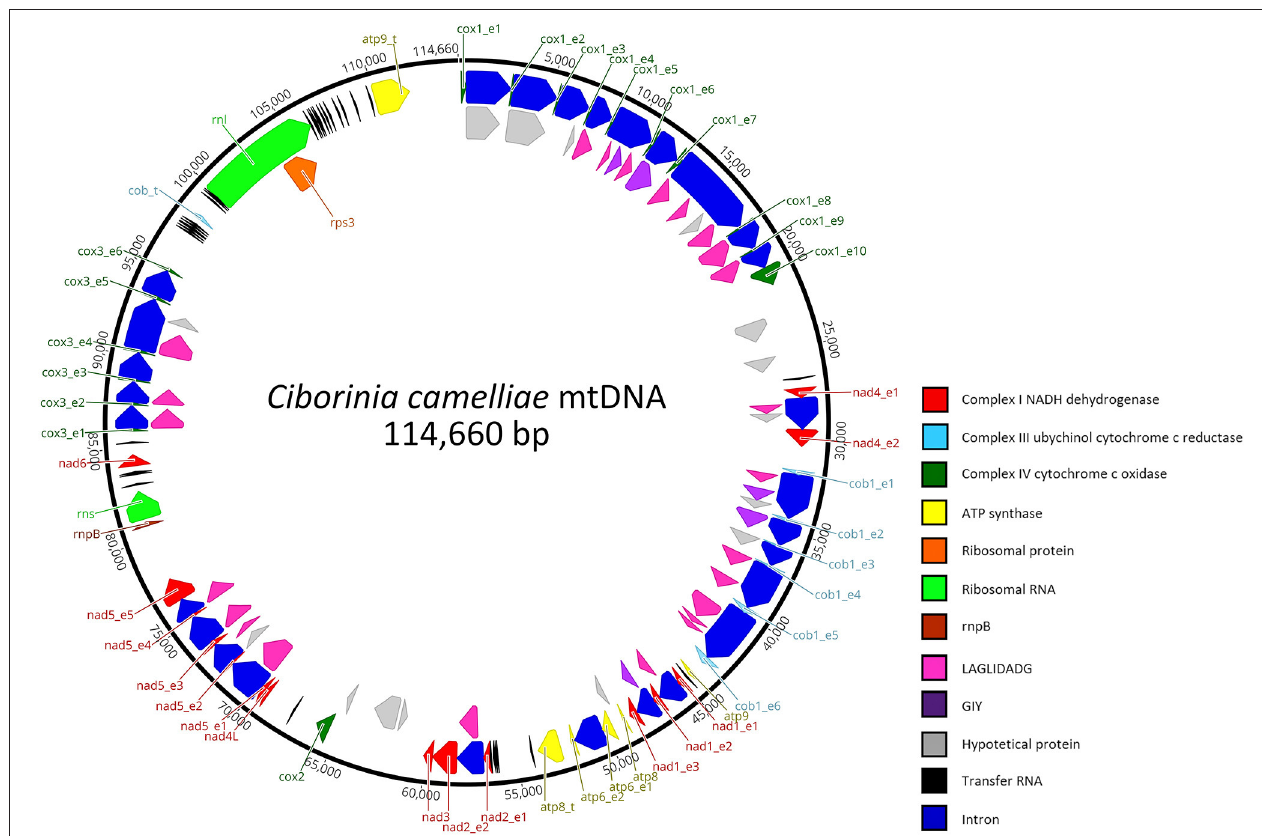
FIGURE 1 | Genetic organization of Ciborinia camelliae mitogenome. Circular map is generated by Geneious Prime software, version 2021.1.1 (Biomatters, Auckland, New Zealand). Genes are represented by different colored